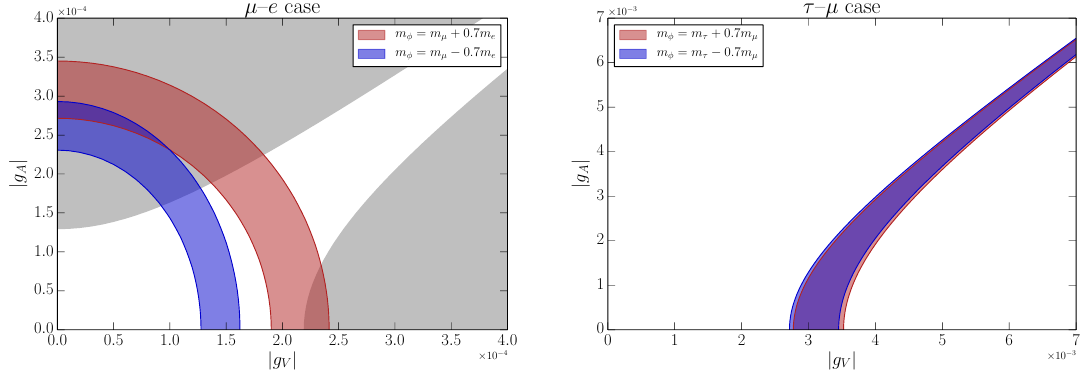
Figure 1 . The parameter regions that explain the muon g − 2 anomaly. Note that the magnetic dipole moments depend only on the absolute values of g V and g A . Left panel: the µ – e case. The red and blue regions explain the muon g − 2 anomaly within 1 σ with m φ = m µ + 0 . 7 m e and m φ = m µ − 0 . 7 m e , respectively, as benchmarks. The gray region is excluded by the electron g − 2 constraint (2.7). We have taken m φ = m µ for the electron g − 2 constraint in this figure, but the electron g − 2 constraint has little dependence on m φ within the mass range of our interest. Right panel: the τ – µ case. The red and blue regions explain the muon g − 2 anomaly within 1 σ with m φ = m τ + 0 . 7 m µ and m φ = m τ − 0 . 7 m µ ,